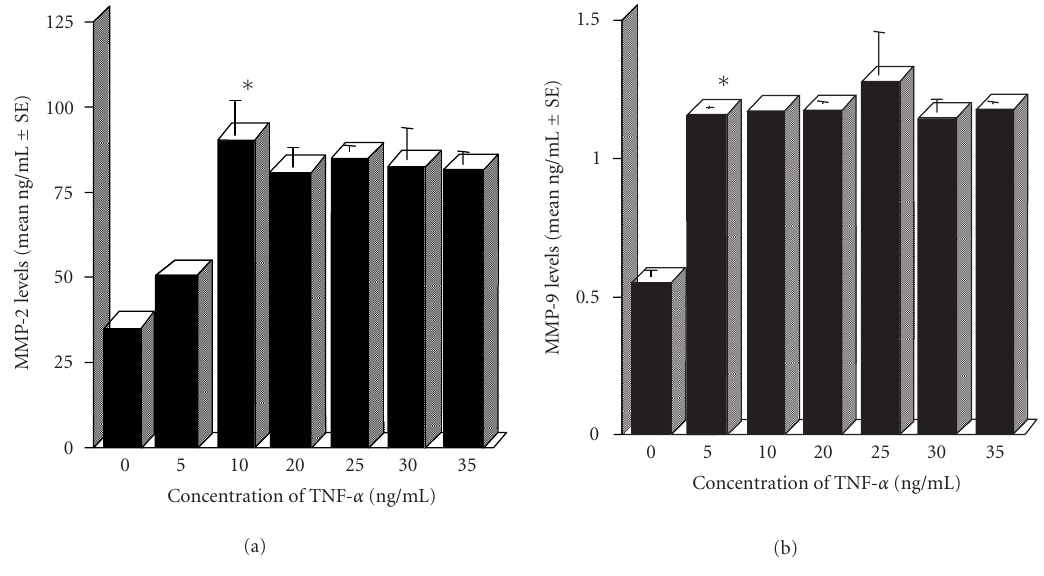
Figure 1. Influence of tumor necrosis factor- α (TNF- α ) on the production of (a) MMP-2 and (b) MMP-9 from nasal polyp fibroblasts. Cells were stimulated with various concentrations of TNF- α for 24 hours. MMP-2 and MMP-9 levels in the culture supernatants were examined by ELISA. Data are expressed as the mean ng/mL ± SE of five di ff erent subjects. ∗ means significant ( P < . 05) compared with 0